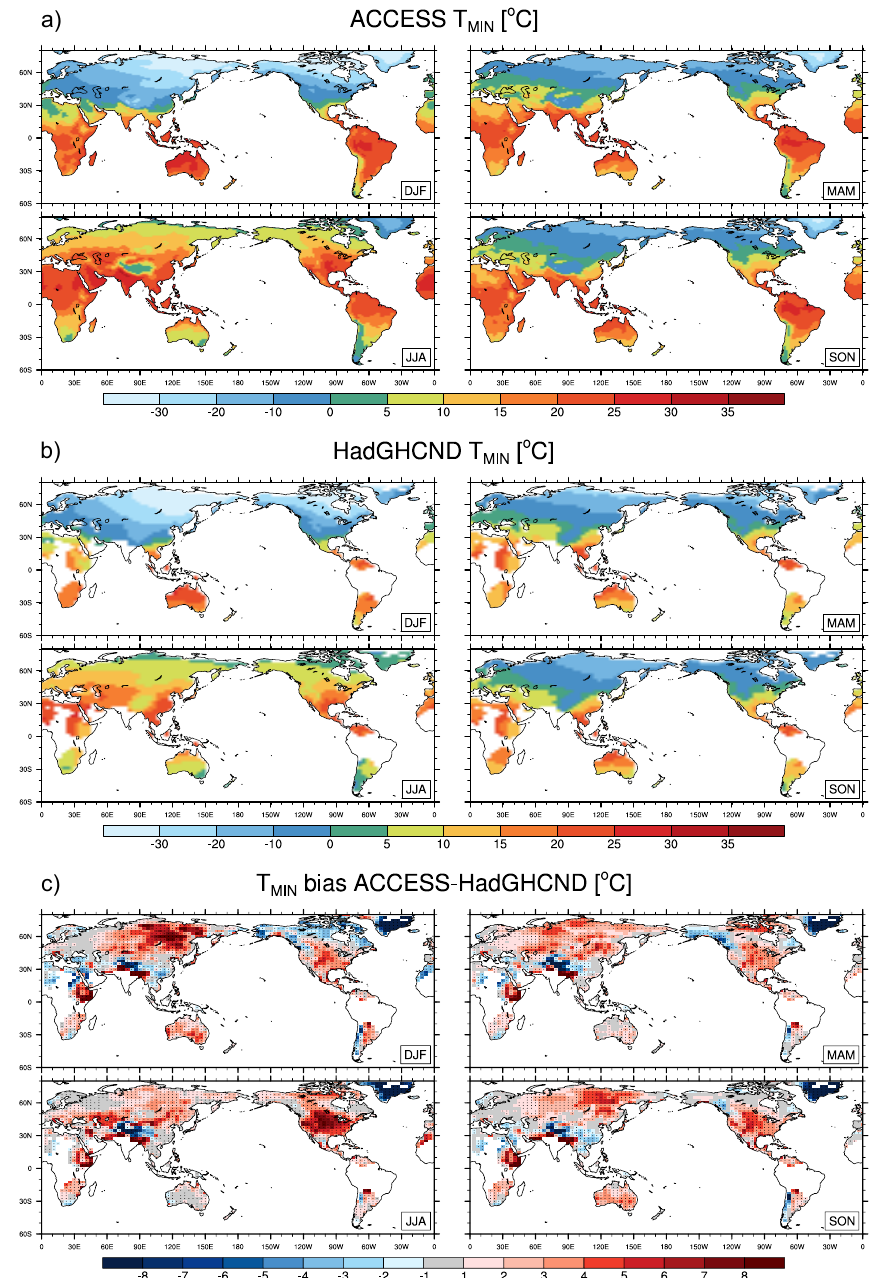
Fig. 2. Daily T MIN for ACCESS1.3b (top row), HadGHCND (middle row) and bias (bottom row). Unshaded areas in (b) and (c) reflect missing observation data. The considered time period is the overlapping time period between model run and observations, 1951–2011. Stippling in (c) indicates areas where bias is statistically significant based on the modified t